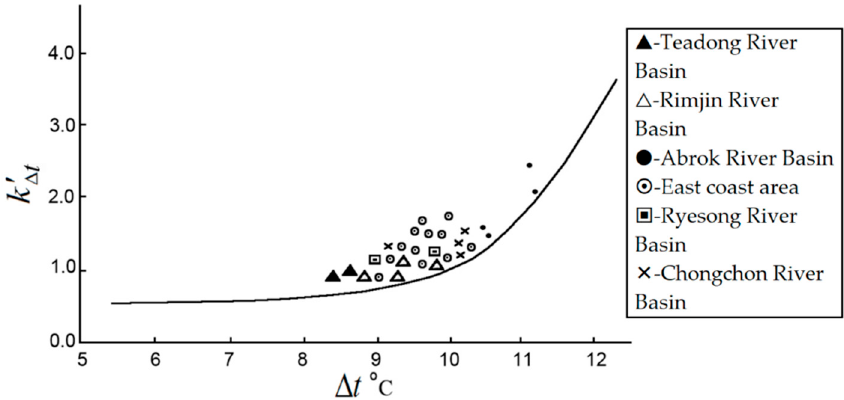
Figure 12. Scatter plot of k (cid:48) ∆